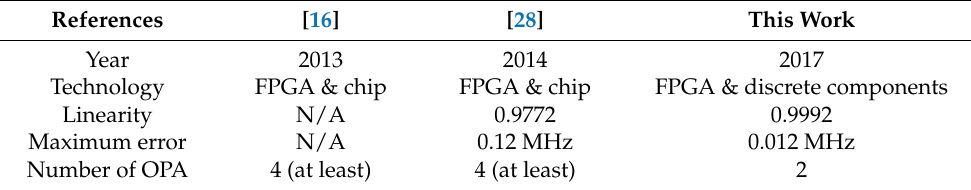
Table 4. Comparison with the previous works.